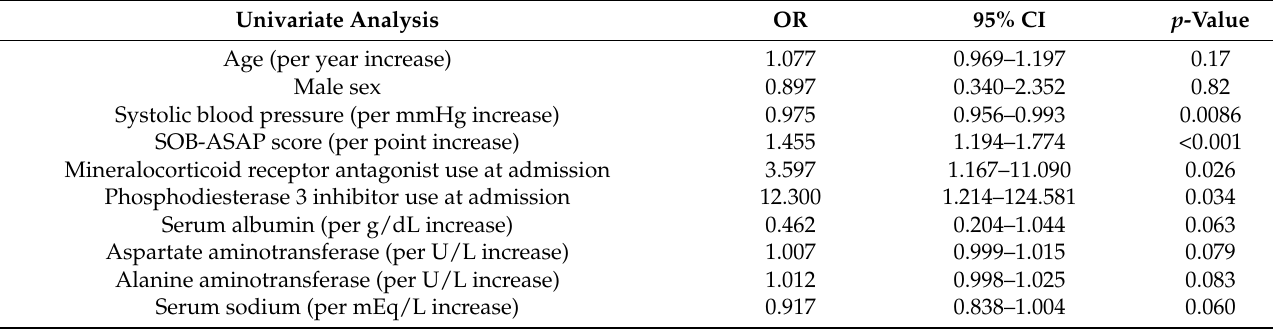
Table 4. Results of the univariate logistic regression analysis and the multivariate stepwise regression analysis for predicting in-hospital